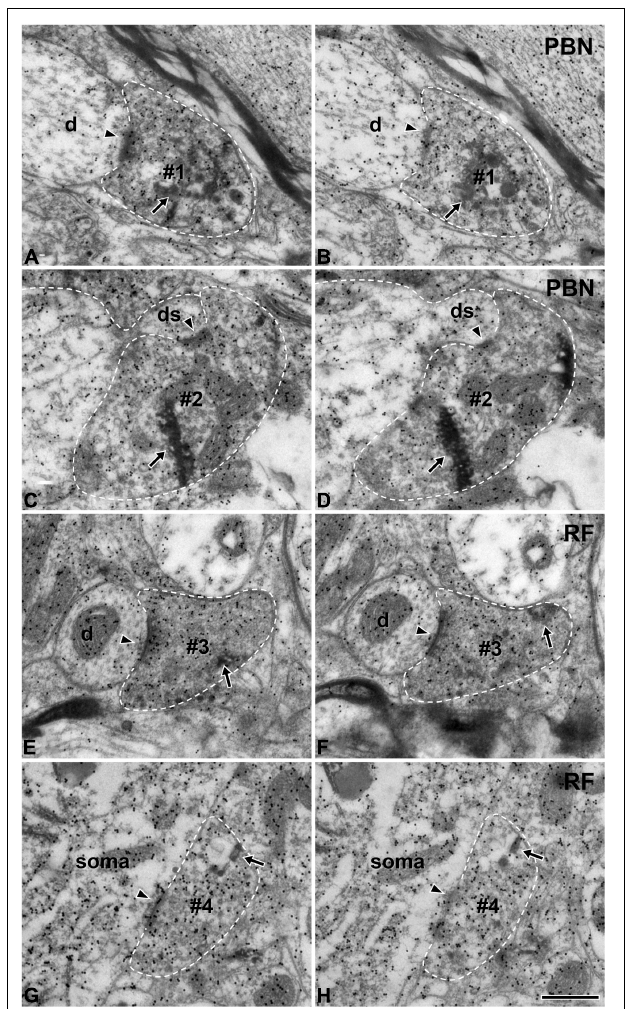
FIGURE 2 | Electron micrographs of immunogold staining for glutamate in adjacent thin sections through anterogradely labeled Glut + terminals (#1–#4) in the parabrachial nucleus (PBN, A–D ) and medullary reticular formation (RF, E–H ) after tracer injection in the rNST. Postsynaptic targets of Glut + labeled terminals (boutons) are different in the PBN and RF. Glut + labeled terminals are presynaptic to the dendritic spine more frequently in the PBN than in the RF, while they are presynaptic to soma or proximal dendrite more frequently in the RF than in the PBN. (A–D) The labeled terminals (#1, #2) in the PBN establish synaptic contacts (arrowheads) with a dendritic shaft (d; A,B ) and a dendritic spine (ds; C,D ). (E–H) The labeled terminals in the RF (#3, #4) establish synaptic contacts (arrowheads) with a small dendritic shaft (d; E,F ) and a cell body (soma; G,H ). The labeled terminals can be identified by the presence of the HRP reaction product (arrows) within the axoplasm. Labeled terminals that are Glut + were analyzed in this study: note the high density of gold particles coding for glutamate over the areas of the axoplasm containing synaptic vesicles. Glut immunoreactivity is consistent in the pairs of serial sections of the labeled terminal, confirming their glutamatergic nature. The labeled terminals and the postsynaptic dendritic spine are outlined with a dashed line for clarity. Scale bar, 500 nm.